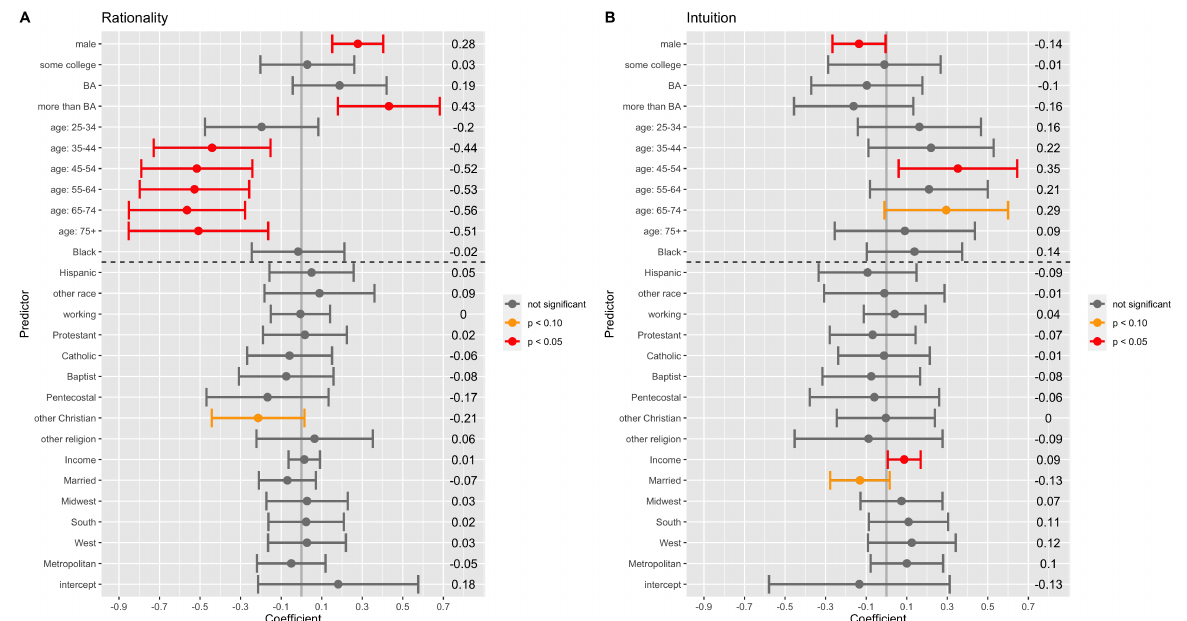
Figure 2: Coefficient plots of linear regressions of cognitive style on demographic variables. Data: Measuring Morality Survey; N = 1, 519. Figures display point estimates and 95 percent confidence intervals. Point estimates are shown along the right side of each